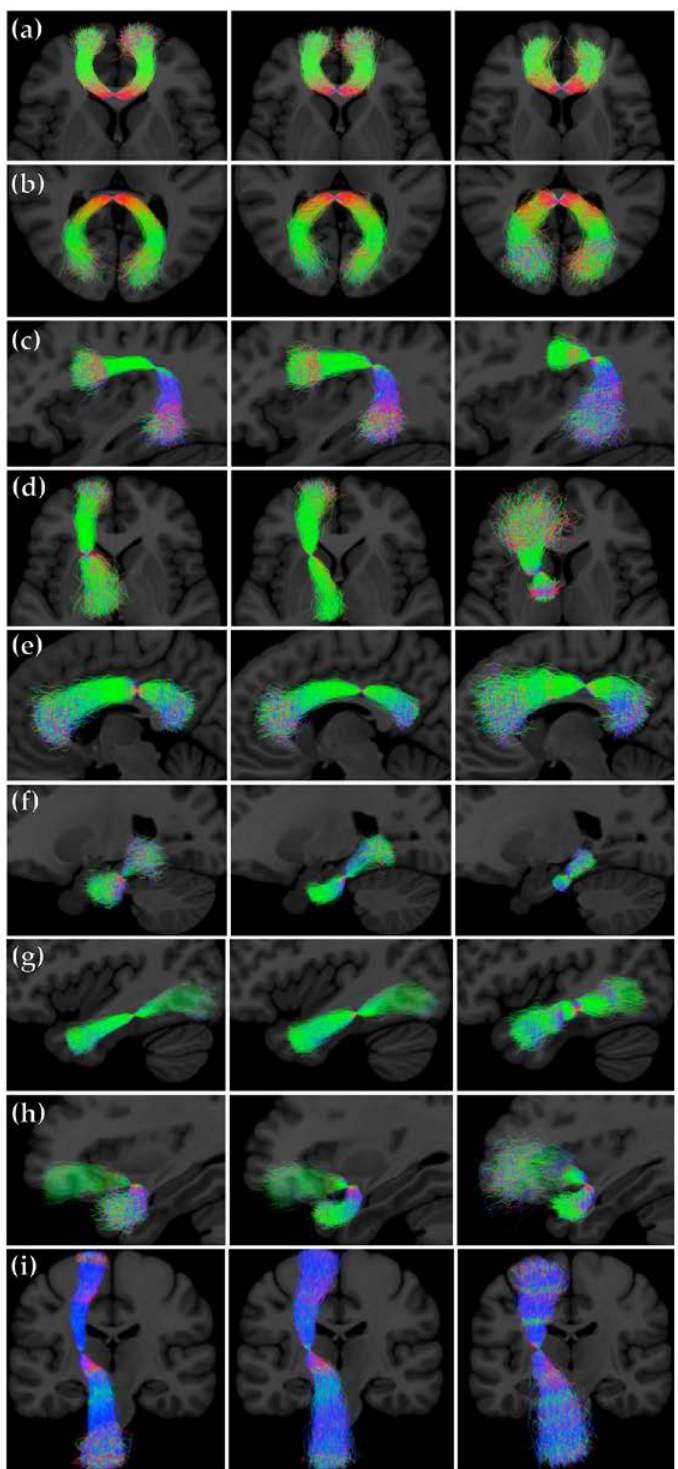
Figure 6. Streamline representations of the synthetic tracts obtained by sampling from the PNT models generated from the training and LBC1936 data. First column: PNT model from the training dataset using the data-based reference tract; second column: PNT model from the LBC1936 dataset using the data-based reference tract; third column: PNT model from the LBC1936 dataset and the atlas-based reference tract. ( a ) genu ( b ) splenium, ( c ) Arc, ( d ) ATR, ( e ) Cing, ( f ) Cing, ventral, ( g ) ILF, ( h ) Unc, and ( i ) CST.